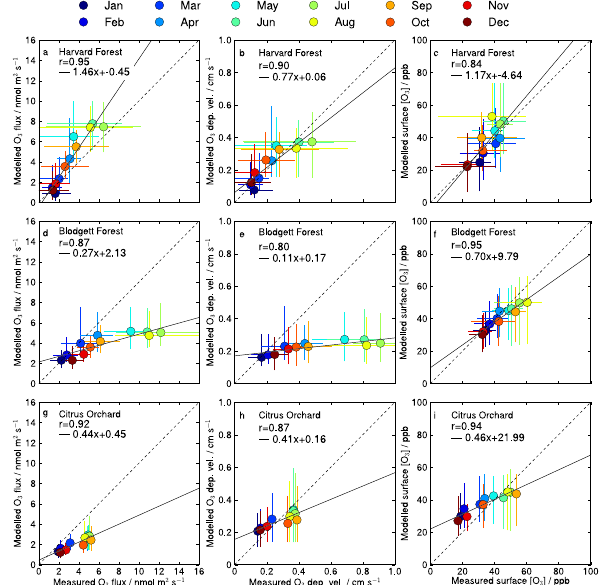
Figure 7. Comparison of observed and modelled monthly aver- age O 3 dry deposition fluxes, O 3 dry deposition velocities and sur- face O 3 at North American measurement sites. Individual sites are shown by row for Harvard Forest (a – c) , Blodgett Forest (d – f) and Californian citrus orchard (g – i) . Observed and modelled fluxes at each site are compared directly in the left hand column, deposi- tion velocities are shown in the middle column, and surface O 3 is compared in the right hand column. Vertical bars represent the range across the models and horizontal bars represent the interan- nual range in the observations, where